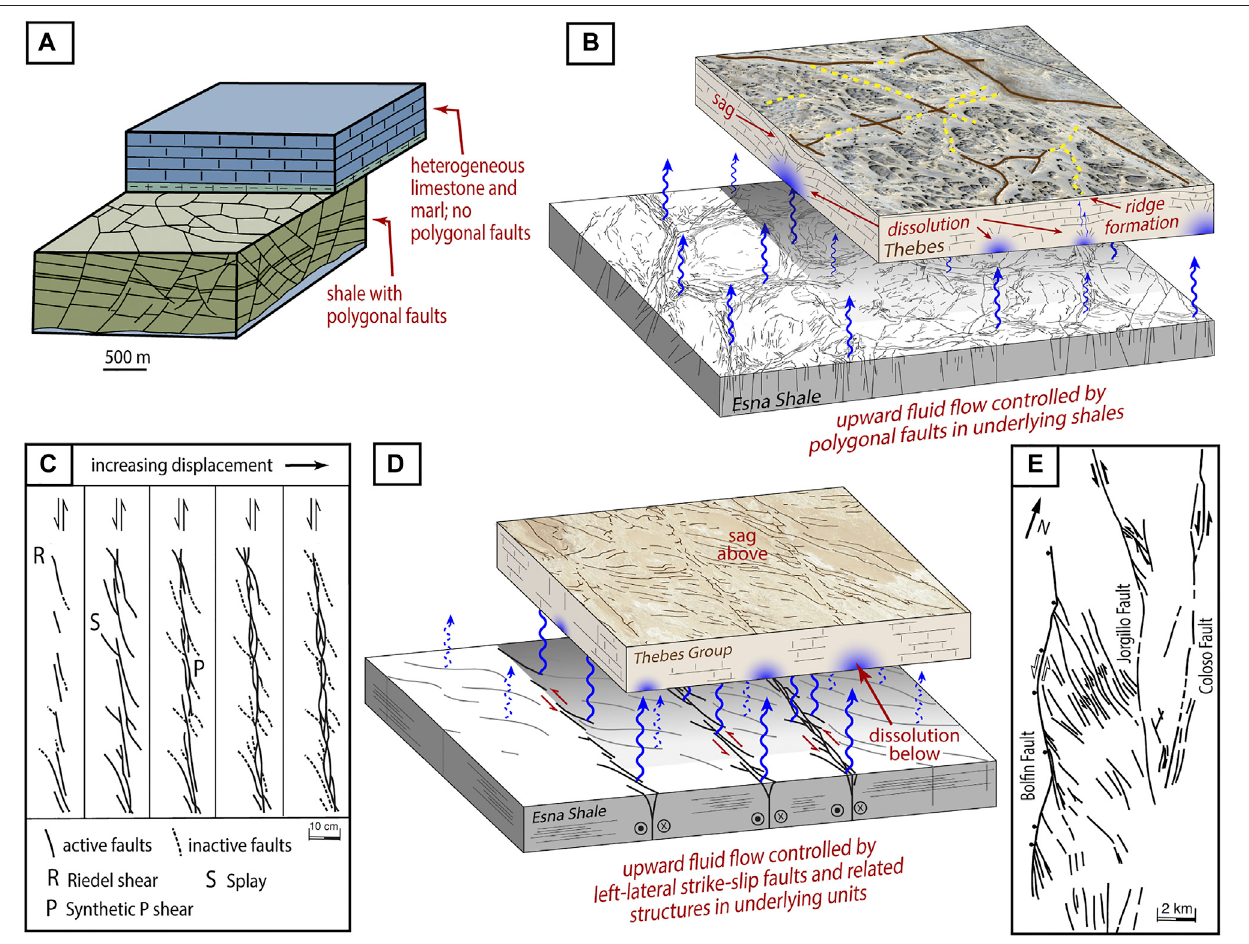
FIGURE 15 | Summary model of bedrock structures controlling upward fl ow of aggressive fl uids through bedrock underlying the Thebes limestones, with hypogene speleogenesis at depth in the limestones and sag in shallower limestone layers to create a sag syncline network with patterns that re fl ect the structural patternsintheunderlyingbedrock. (A) Schematicdiagramshowingplanformandscaleofpolygonalfaults.AdaptedfromCartwright(1994)toshowpolygonalfaults only in layers susceptible to polygonal faulting during early burial and diagenesis. (B) Conceptual model of polygonal faults in underlying shale controlling upward fl uid fl ow into Thebes limestones. The pattern of polygonal faults is based on real-world polygonal faults as mapped by Tewksbury et al. (2014) in Cretaceous chalk of the Khoman Formation, which is well-exposed at the surface near Farafra Oasis, Egypt. (C) Diagram (Naylor et al., 1986) showing sequence of structures developed in analog models during upward propagation of a left-lateral strike-slip fault. Modi fi ed with permission from Elsevier. (D) Conceptual model of underlying, largely blind, left-lateral strike-slip faults in the N – S zones and related structures in the panels controlling upward fl uid fl ow into Thebes limestones. (E) Structures with Lazy-S geometry developed between two left-lateral strike-slip faults in the Atacama Desert. Modi fi ed from Cembrano et al. (2005) with permission from Elsevier .